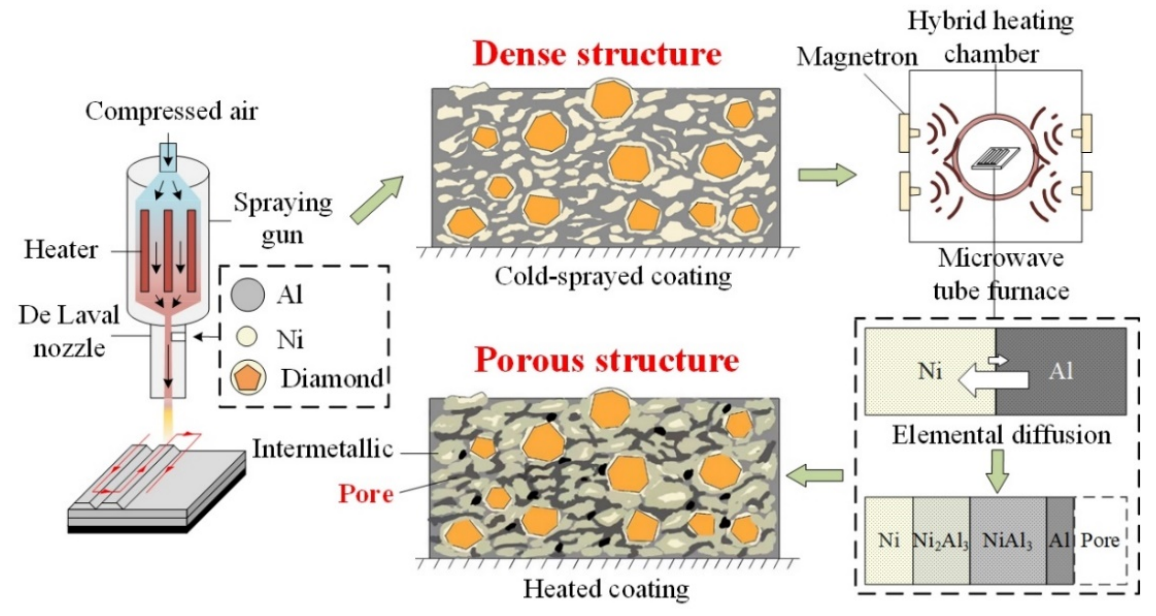
Figure 1. Fabricating porous metal-bonded diamond coatings based on low-pressure cold spraying and Ni-Al diffusion–reaction.